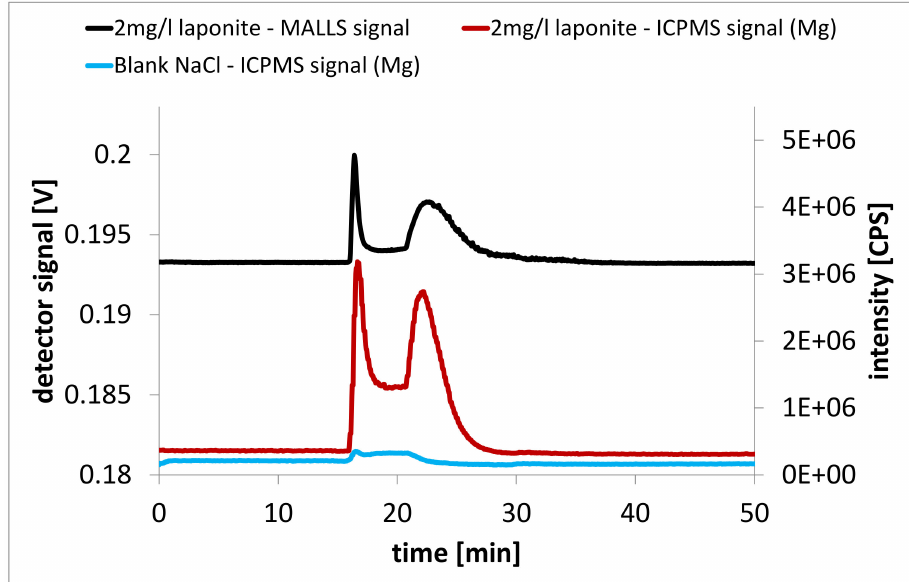
Figure 5. Comparison between AF4/MALLS and AF4/ICPMS measurements of a 2 mg/L laponite dispersion. Black is the signal recorded by the MALLS detector (caused by laponite particles) and red is the signal of the ICP-MS for Mg at identical elution times. Blue is the signal for Mg of the NaCl in 3% HNO 3 blank (shifted by − 1.5 × 10 5 CPS for better differentiation).